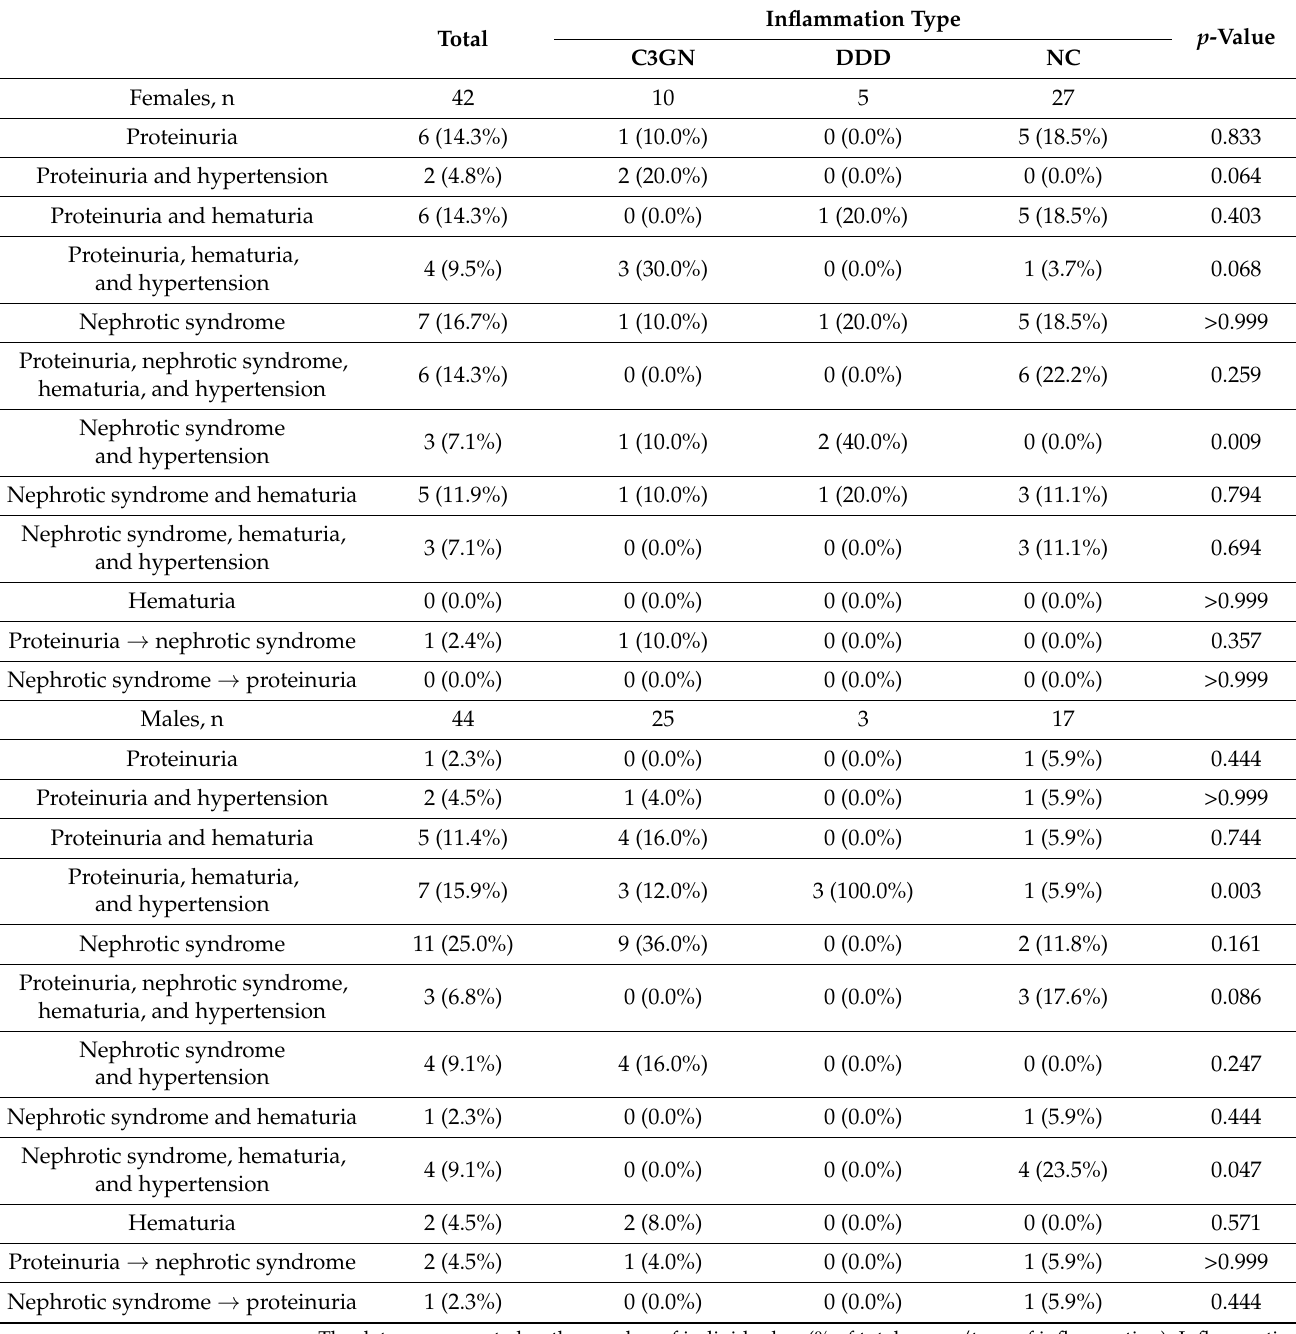
Table A2. A detailed list of the clinical symptoms in